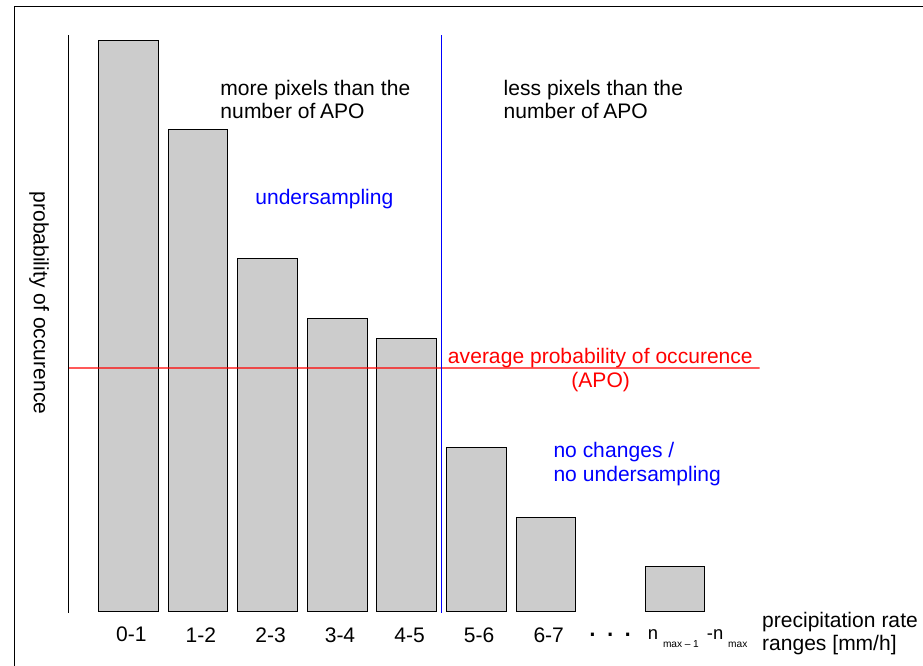
Figure 4. Overview of the first undersampling method.